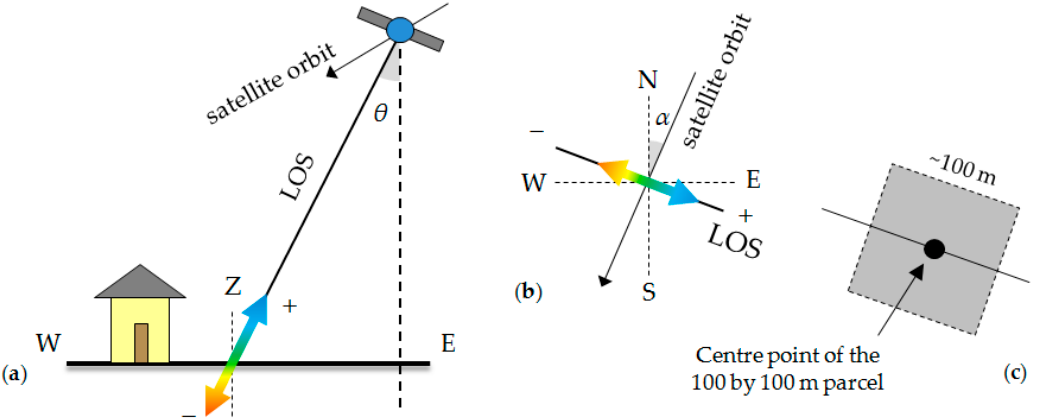
Figure 5. ( a ) Vertical and ( b ) planar view of the satellite Line-Of-Sight (LOS) in descending mode; and ( c ) schematic representation of each low resolution parcel for which the ground motion is estimated.